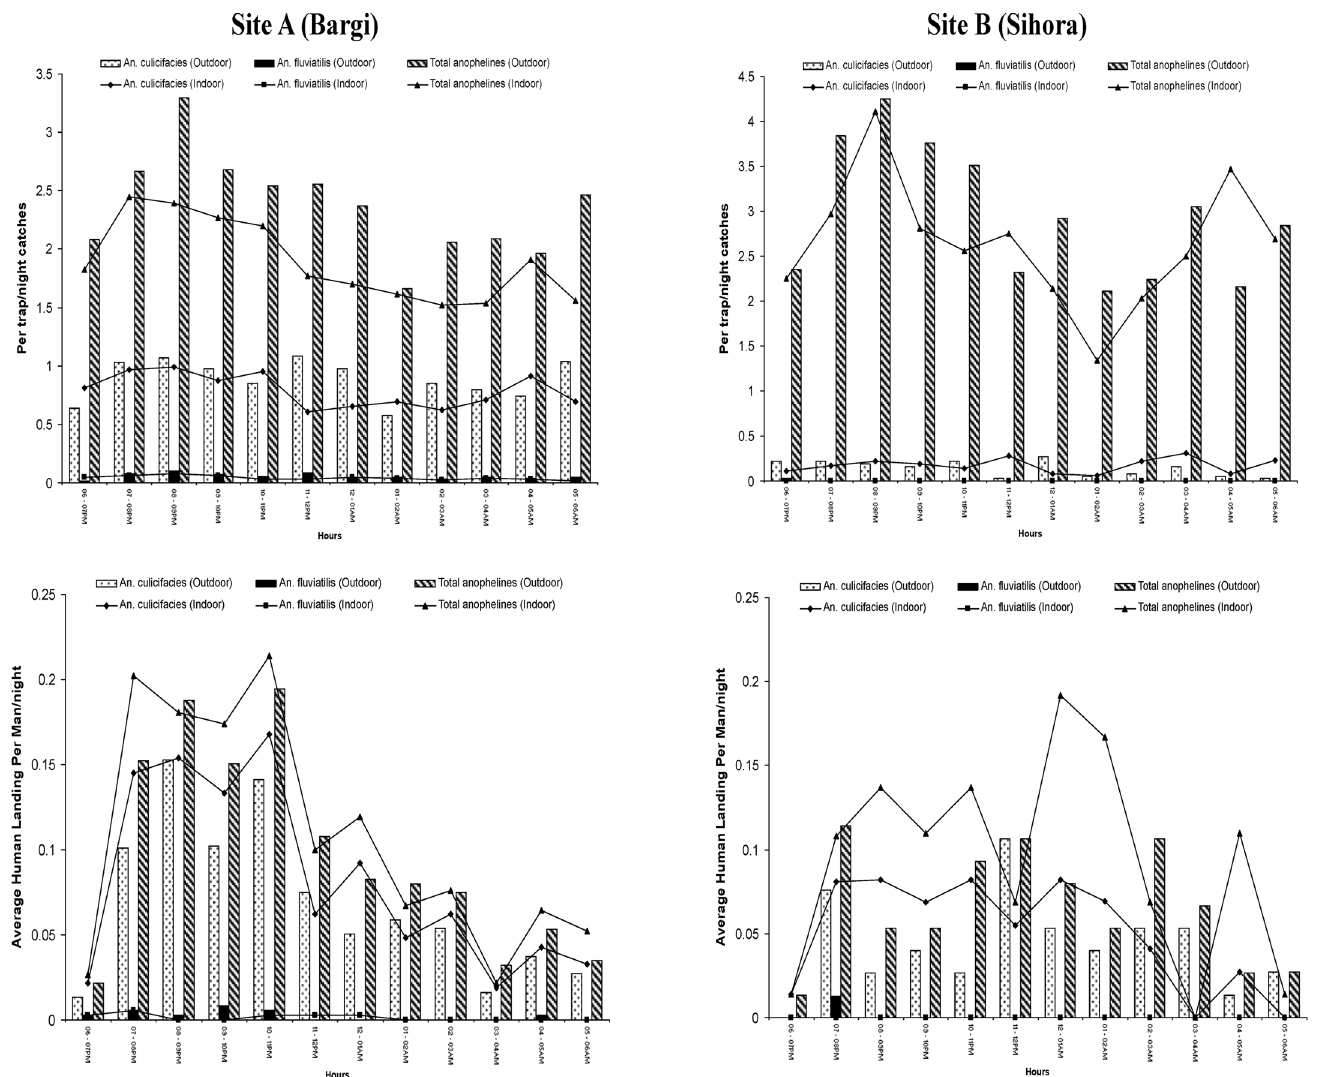
Fig 4. Showing hourly trap catches and human landing catches of An . culicifacies and An . fluviatilis in indoor and outdoor in study villages of district Jabalpur.